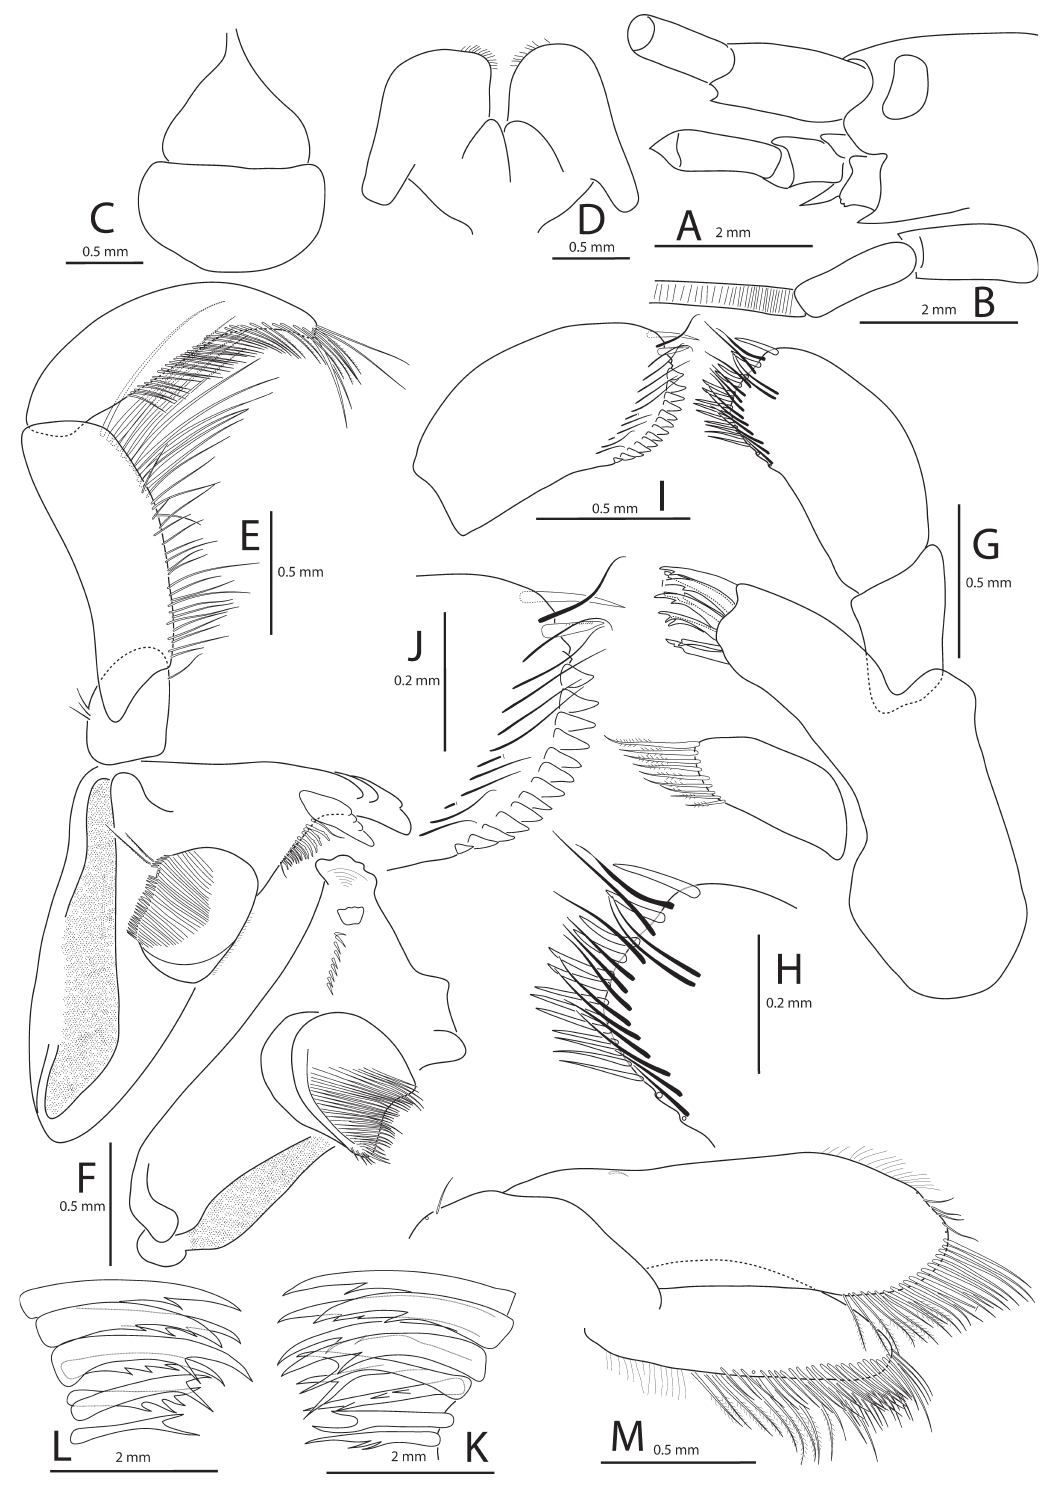
Fig. 3. Halirages cainae sp. nov., holotype ♂, 40 mm, Norwegian Sea, MAREANO 2009-111, R-station 487, sample 157. A . head and remaining parts of left antennae. B . right A2. C . upper lip and epistome. D . lower lip. E . left Md. F . right Md. G . left Mx1. H . tip of palp of left Mx1. I . article 2 of palp of right Mx1. J . tip of palp of left Mx1. K . tip of upper plate of left Mx1 (spines for next intermoult inside old cast). L . tip of upper plate of right Mx1 (spines for the next intermoult inside old